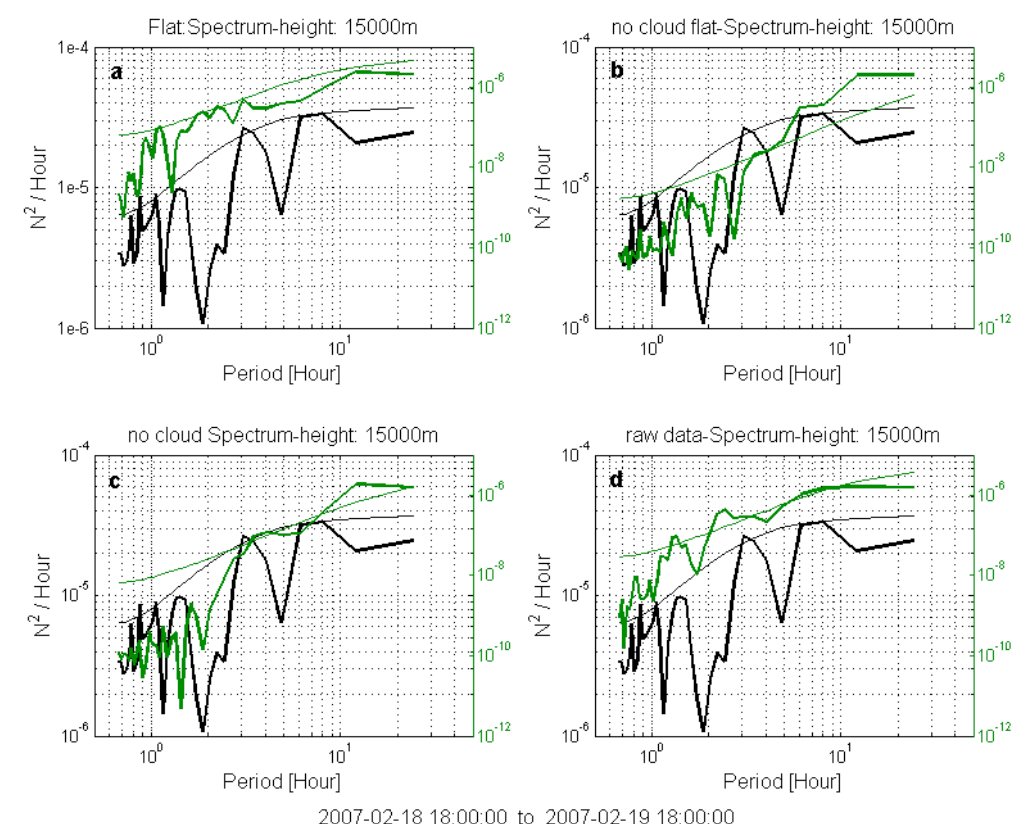
Fig. 4. Spectrum of time series of N at 15000m height, from 18:00UTC on 18 February 2007 to 18:00UTC on 19 February 2007. The black line in all panels shows the spectrum obtained from ESRAD, the green lines show the results from the WRF model experiments. The 95% confidence level (thin green and black curves). (a) simulation with clouds but without orography; (b) simulation without clouds and without orography; (c) simulation without clouds but with orography; and (d) simulation with clouds and with orography.